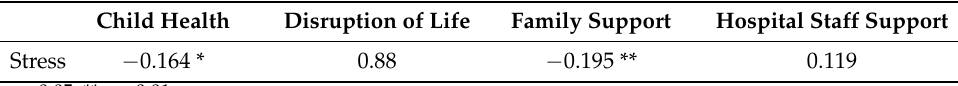
Table 3. Correlations between parental stress and other variables.